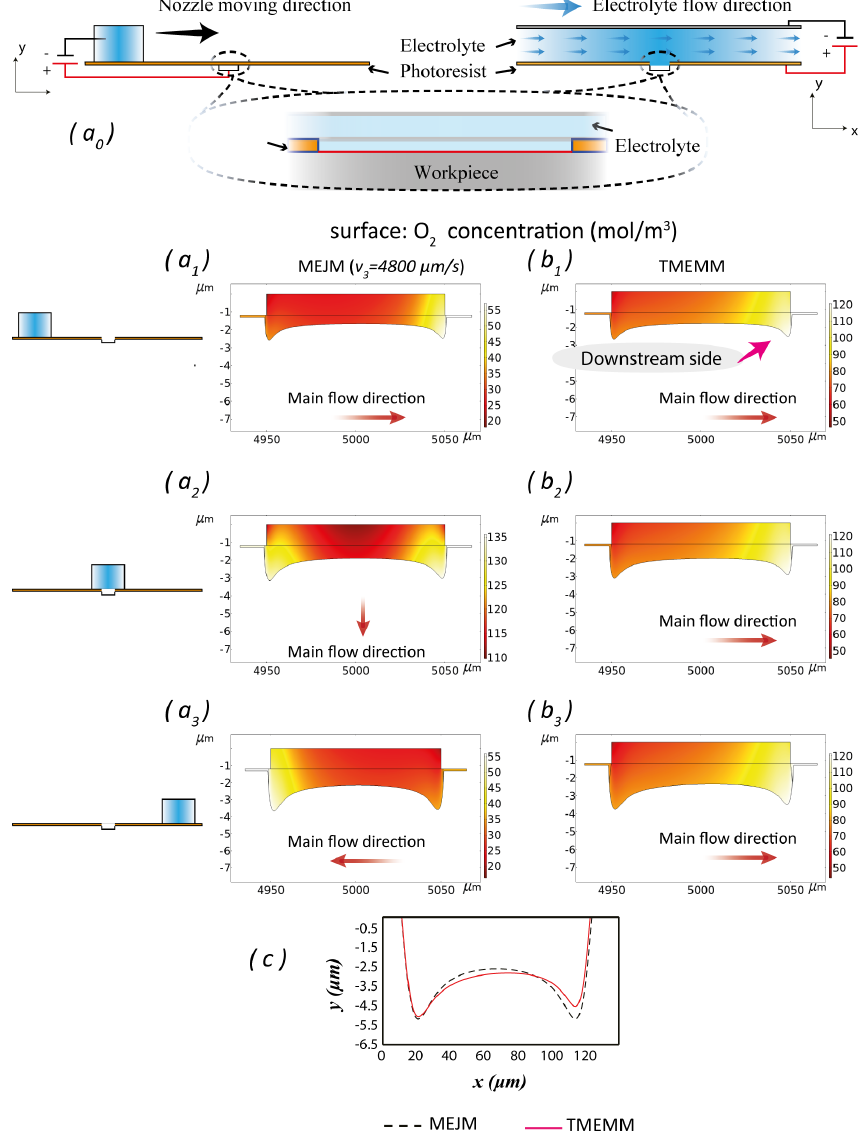
Figure 13. ( a 0 ) Schematic of simulations between MEJM and TMEMM; concentration of O 2 in different environments: ( a 1 – a 3 ) MEJM with different nozzle positions; ( b 1 – b 3 ) TMEMM with the same maximum depth. ( c ) Comparison of simulated profiles of MEJM and TMEMM at the same maximum